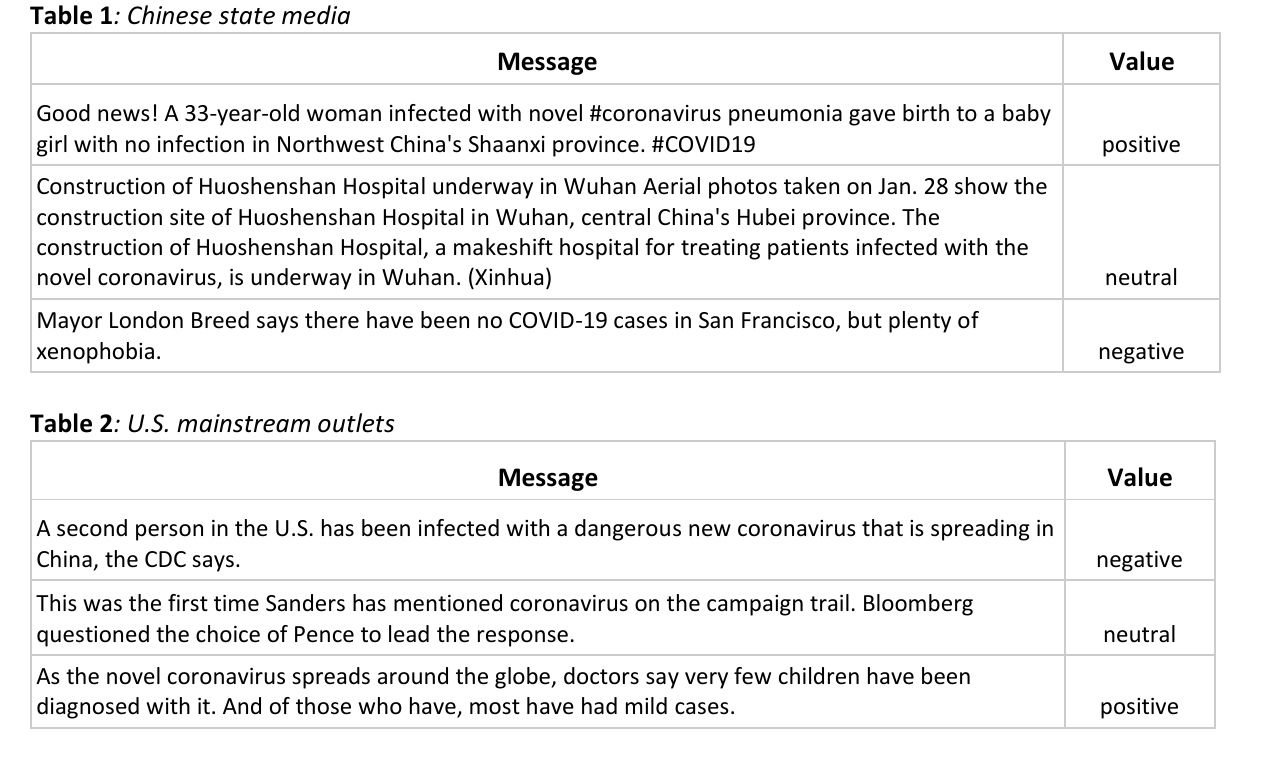
Table 3 : U.S. government-funded